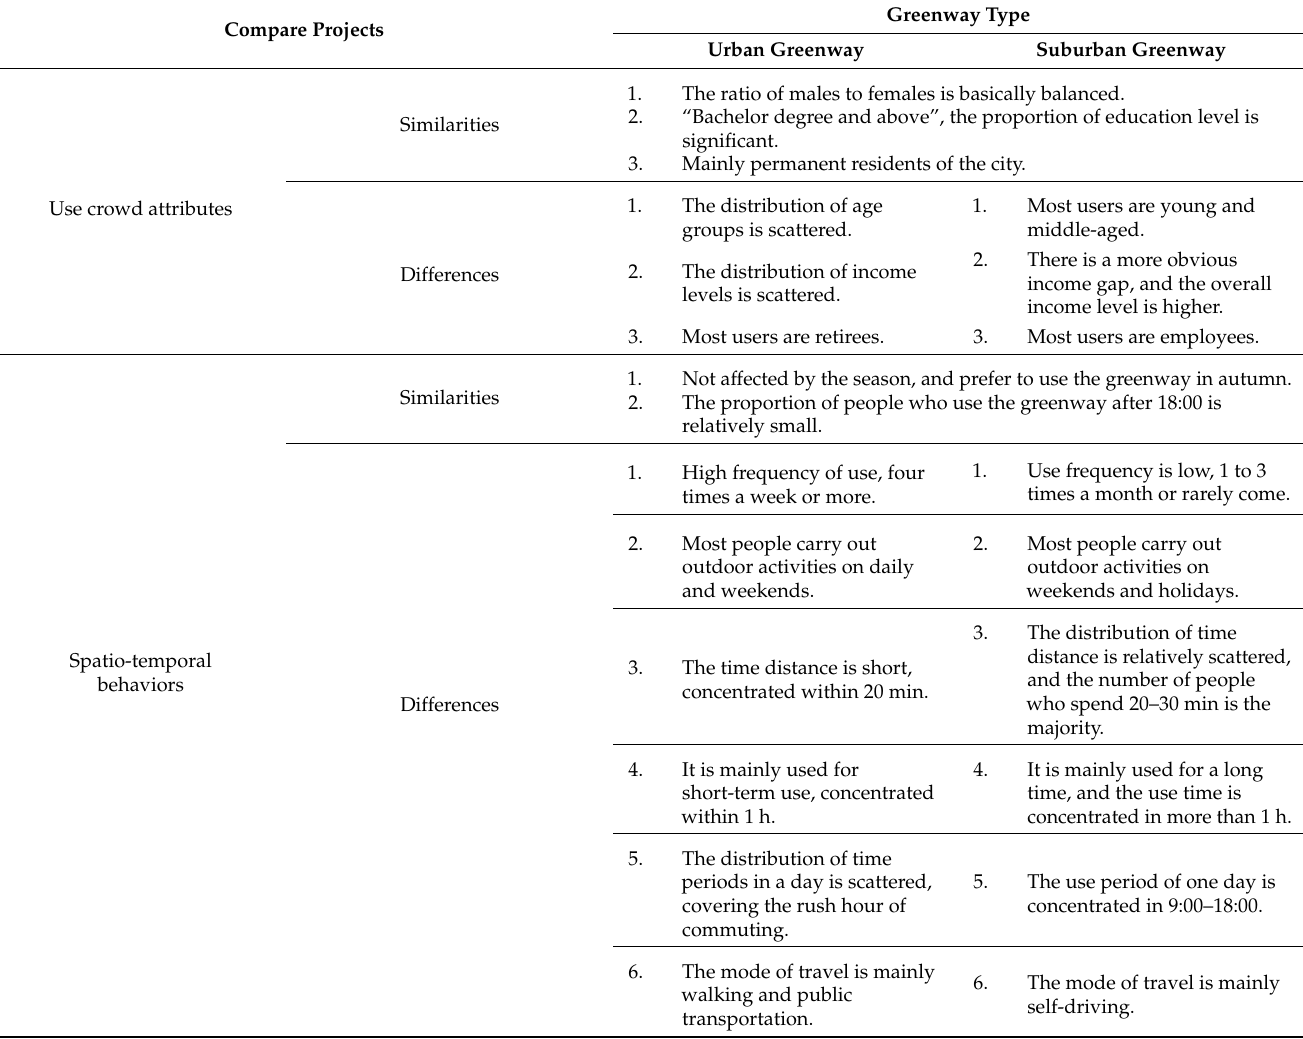
Table 7. Summary of the use characteristics of the two types of